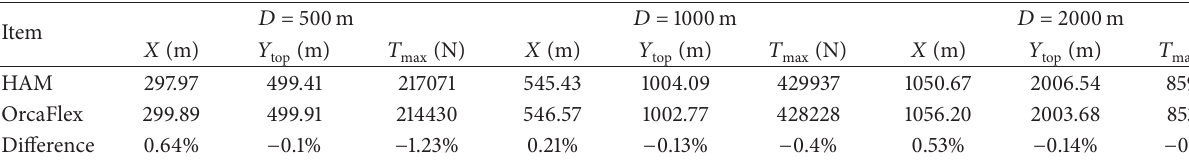
Table 2: Critical results.